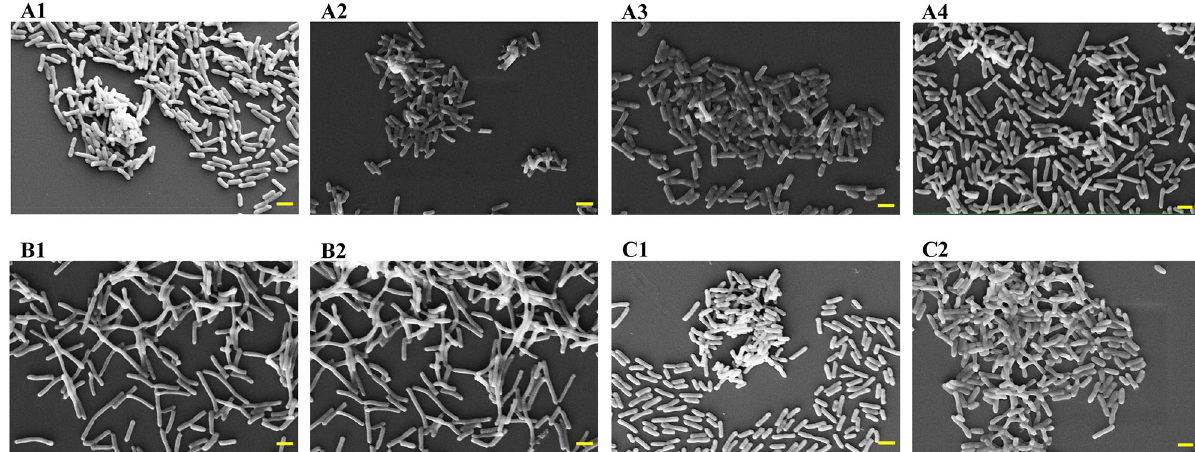
Figure 4. Morphology of E. coli cells after MIR-FEL irradiation or ND: YAG laser irradiation. Images of E. coli obtained with a scanning electron microscope operating at 10 kV are shown. ( A1 ) Untreated group (control); ( A2 ) 6.62-µm MIR-FEL irradiation group; ( A3 ) 6.88-µm MIR-FEL irradiation group; ( A4 ) 7.14-µm FEL irradiation group; ( B1 ) control for the 9.26-µm MIR-FEL irradiation group; ( B2 ) 9.26-µm MIR-FEL irradiation group; ( C1 ) control for the ND: YAG irradiation group; ( C2 ) 15-min Nd: YAG laser irradiation group; scale bars, 2